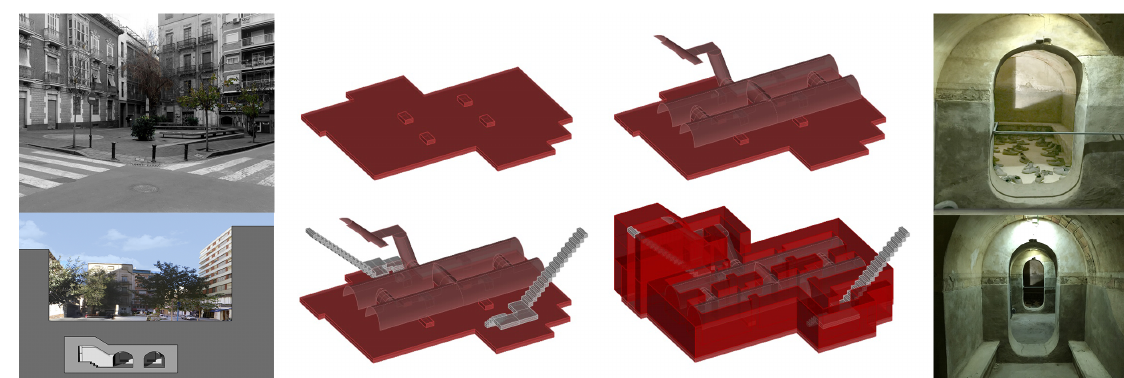
Figure 4. Plan of the Plaza Balmis shelter, with the six cells connected in both directions forming two large longitudinal naves. The lateral images show the access and section of the square ( left ) and the interior of the refuge ( right ). (Own